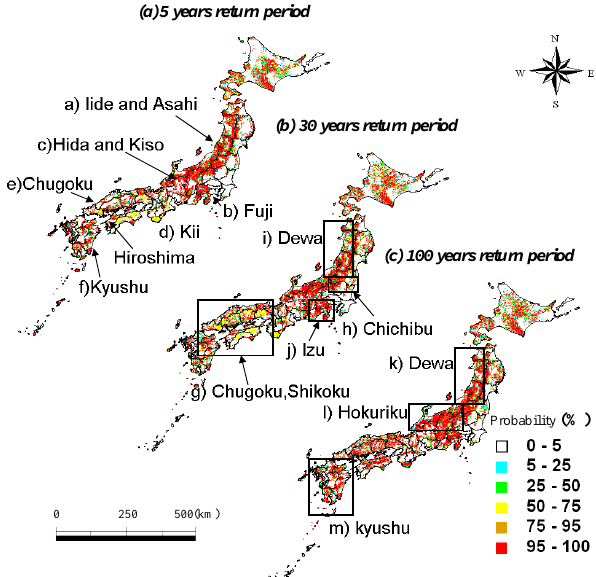
Fig. 6. Developed landslide hazard probability maps; (a) for ex- Figure 6. Developed landslide hazard Probability map; (a) For extreme precipitation 5 years return period, (b) For extreme precipitation 30 years return period, (c) For extreme treme precipitation in 5 years return period, (b) for extreme precipi- precipitation 100 years return period tation in 30 years return period, (c) for extreme precipitation in and 100 years return